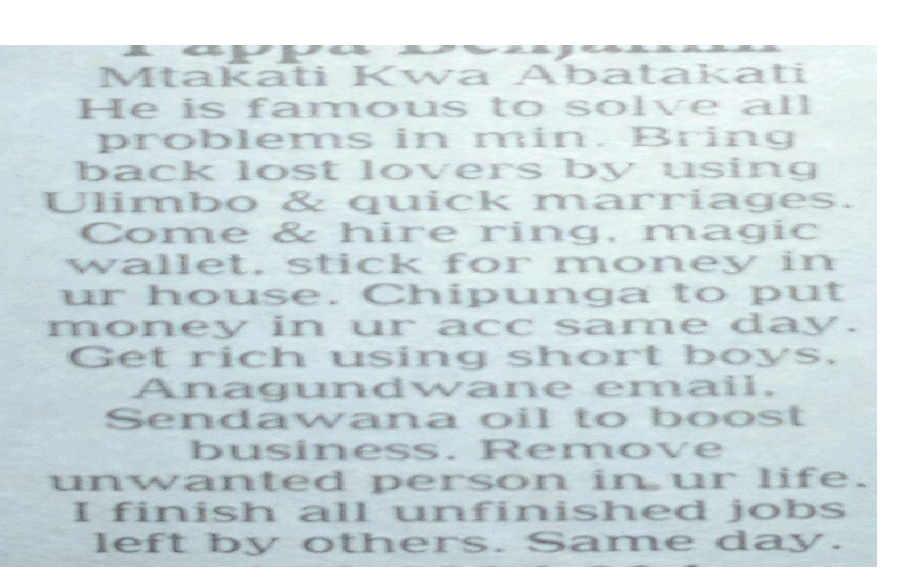
Figure: Example of the newspaper item – Sunday World, 2013